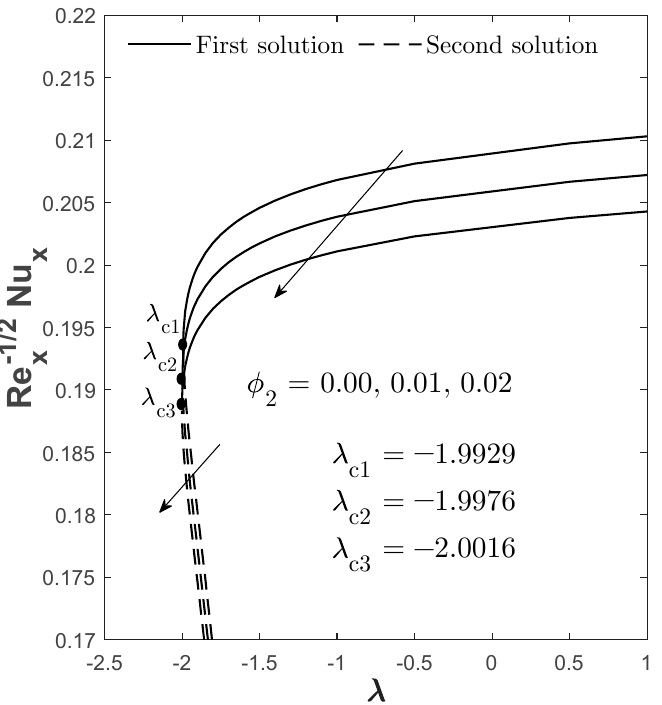
Figure 3. Re − 1/2 x Nu x for varied φ 2 when N = Rd = Sc = Sr = 1, Du = 0.03, and Bi = Figure 3. for varied Nu − for varied Figure 3. 1/2 Re x x